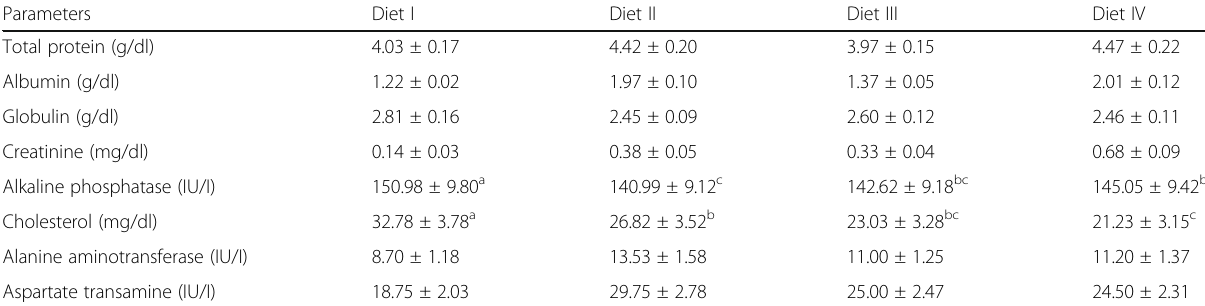
Table 8 Serum indices of broiler chicken fed with diets containing graded level of fortified bread waste meals Parameters